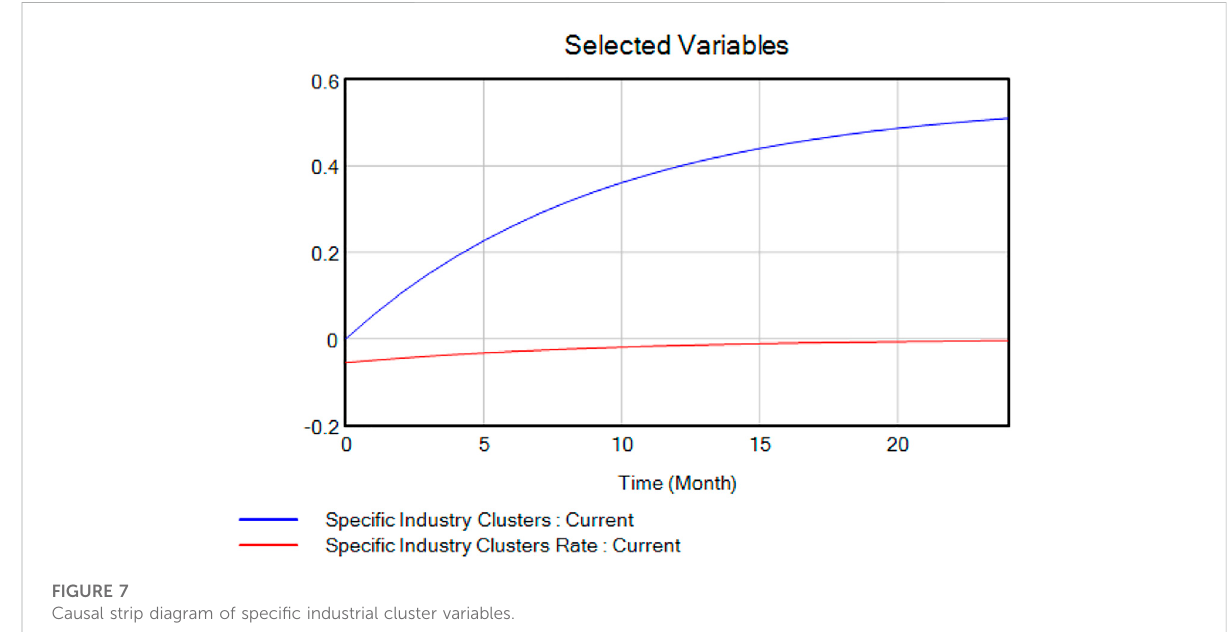
FIGURE 7 Causal strip diagram of speci fi c industrial cluster